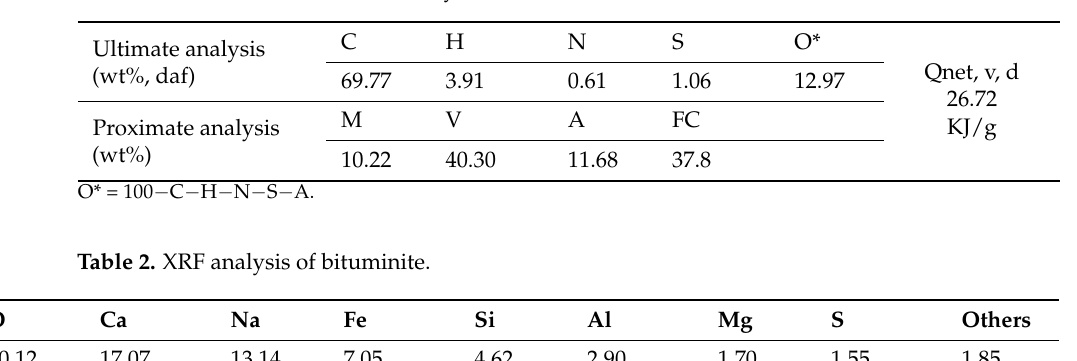
Table 1. Proximate and ultimate analysis of coal.